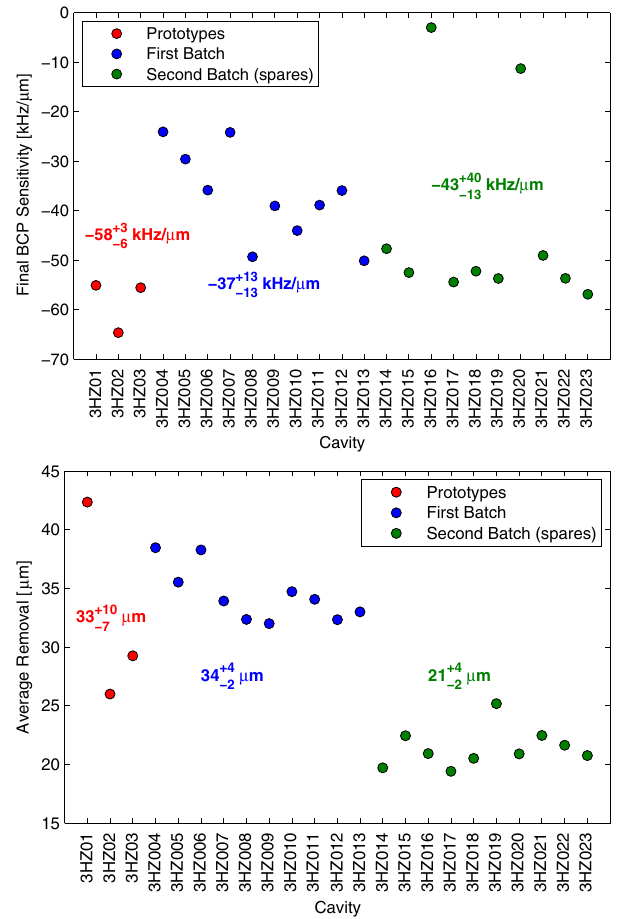
FIG. 8. Above: Individual frequency response of the cavities to the final BCP etching (in units of kHz = μ m of average material removal). A better stability was partially achieved in the spare series, with the notable exception of two treatments which resulted in an unexpected sensitivity even if all process param- eters were in the nominal range. Below: Average thickness removal from the cavity during the treatments (30 min for Prototypes and the 1st batch and 15 min for the 2nd